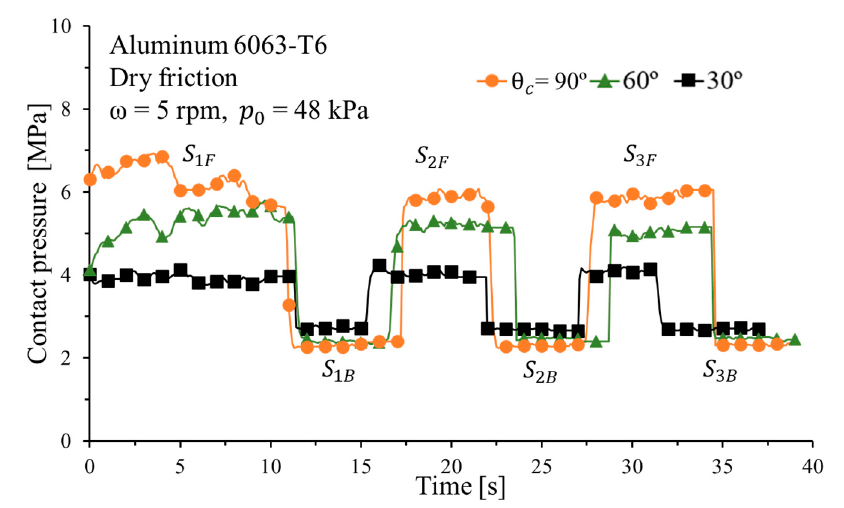
Figure 13. Contact pressure variations with different contact angles for Al6063-T6.